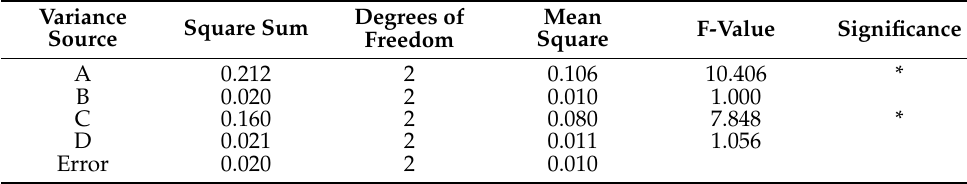
Table 4. The results of the variance analysis of the orthogonal